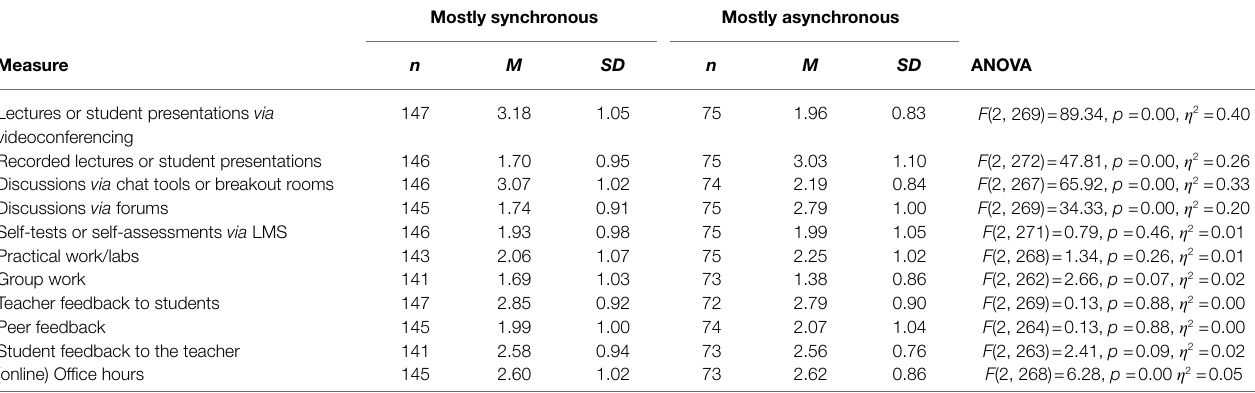
TABLE 4 | Descriptive results for groups and group comparisons of teacher perceptions of teaching and learning methods. Mostly synchronous Mostly